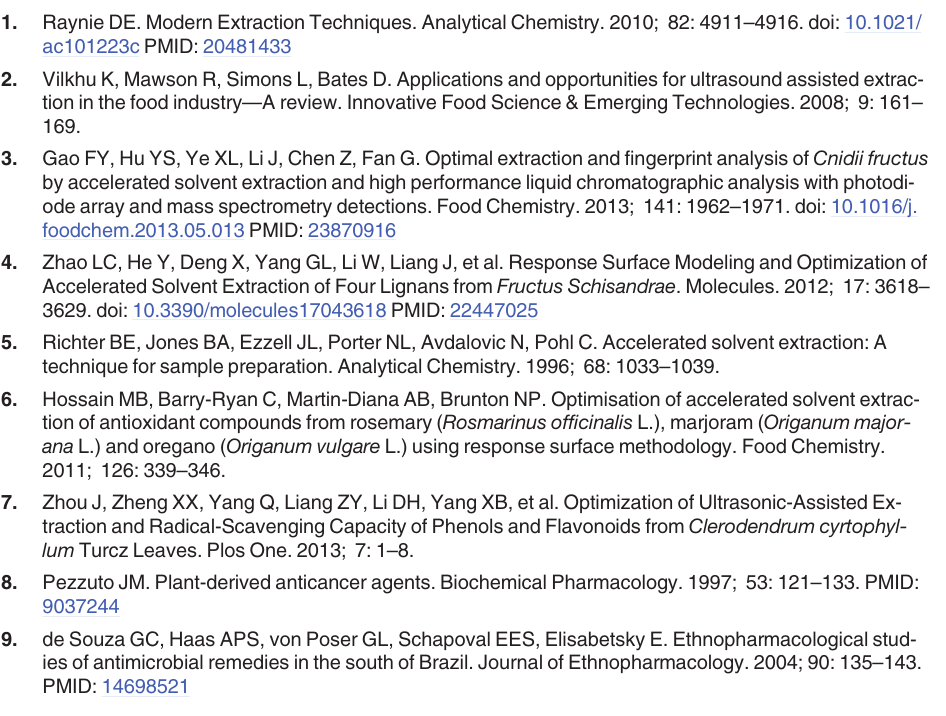
S1 Table. Factorial design and results. S2 Table. Response surface methodology and